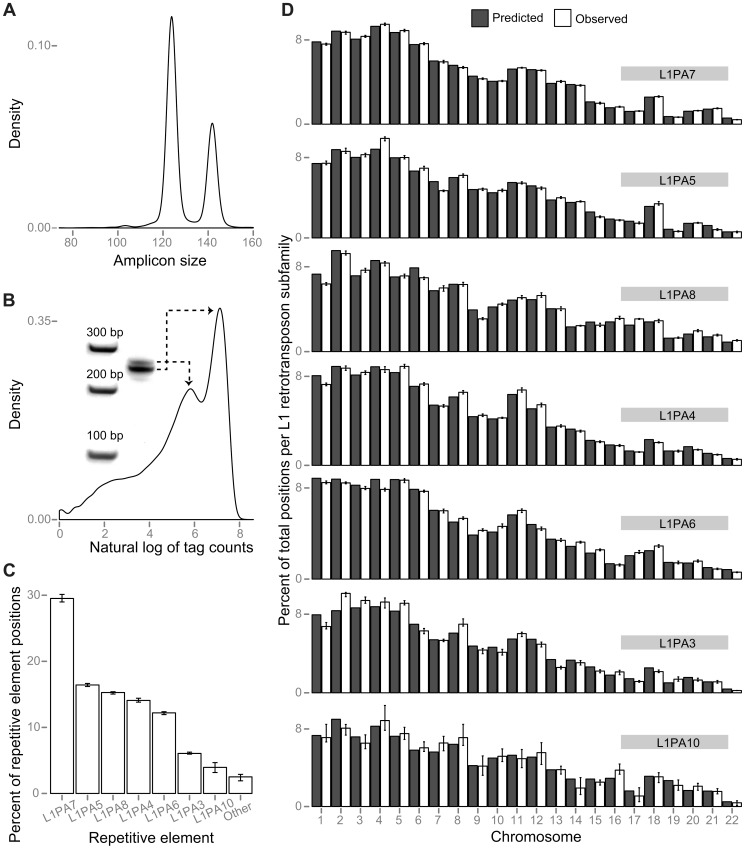
Comparison of observed and predicted distributions of FAST-SeqS amplification products.(A) A density plot of the expected distribution of fragment lengths, with peaks at 124 and 142 bp. (B) A density plot of the actual tag counts obtained in eight normal plasma DNAs. The 124 bp fragments are preferentially amplified compared to the 142 bp fragments, likely due to an amplification bias towards smaller fragments. Inset: polyacrylamide gel of a representative FAST-SeqS sequencing library. Note: the amplification products contain an additional ∼120 bp of flanking sequence to facilitate sequencing (Table S2). (C) The average representation of the most frequently observed L1 retrotransposon subfamilies in eight normal plasma samples. Roughly 97% of uniquely aligning tags arise from positions representing only seven L1 retrotransposon subfamilies. (D) A detailed examination of the average number of observed positions per chromosome from eight normal plasma DNAs compared with the number predicted by RepeatMasker for each of the seven L1 retrotransposon subfamilies noted in (C). Error bars in each panel depict the range.